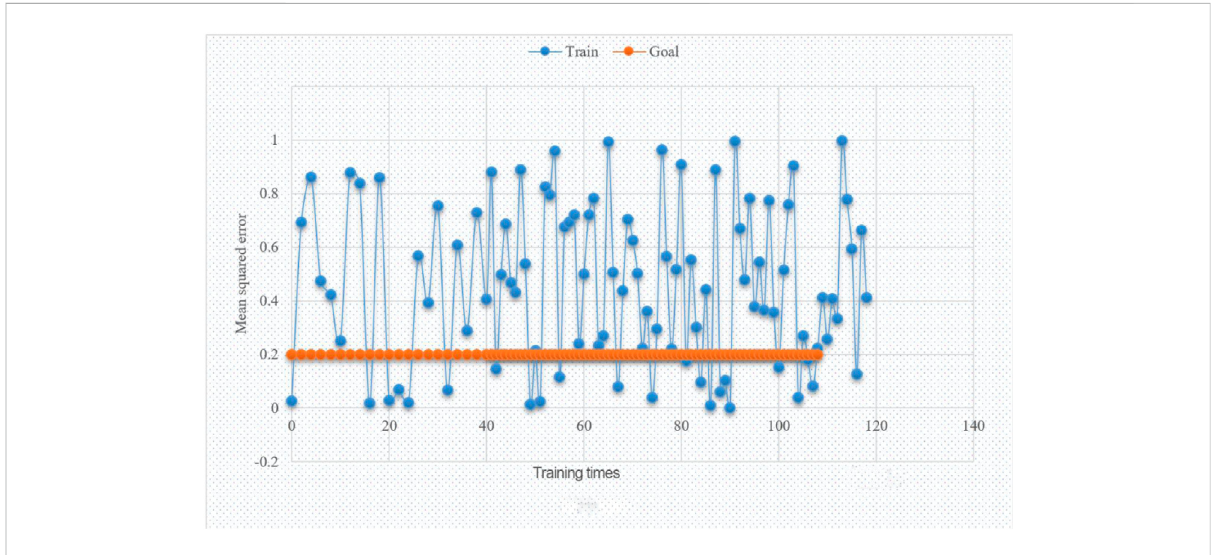
FIGURE 4 Number of training steps and mean squared